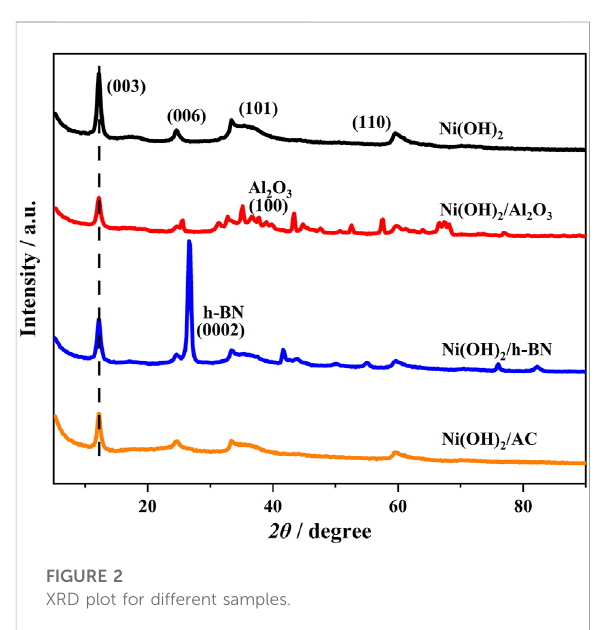
FIGURE 2 XRD plot for different